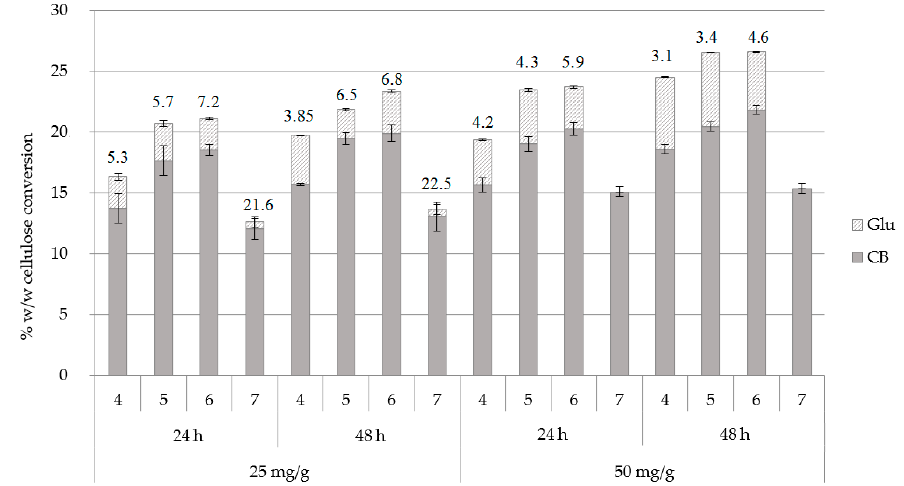
Figure 3. Cellulose conversion (% w/w) to cellobiose (CB) and glucose (Glu) in different pH conditions and at an enzyme loading of 25 and 50 mg/g of substrate, upon buffer exchange at 24 h. The CB:Glu ratio is also described for 24 and 48 h of hydrolysis.